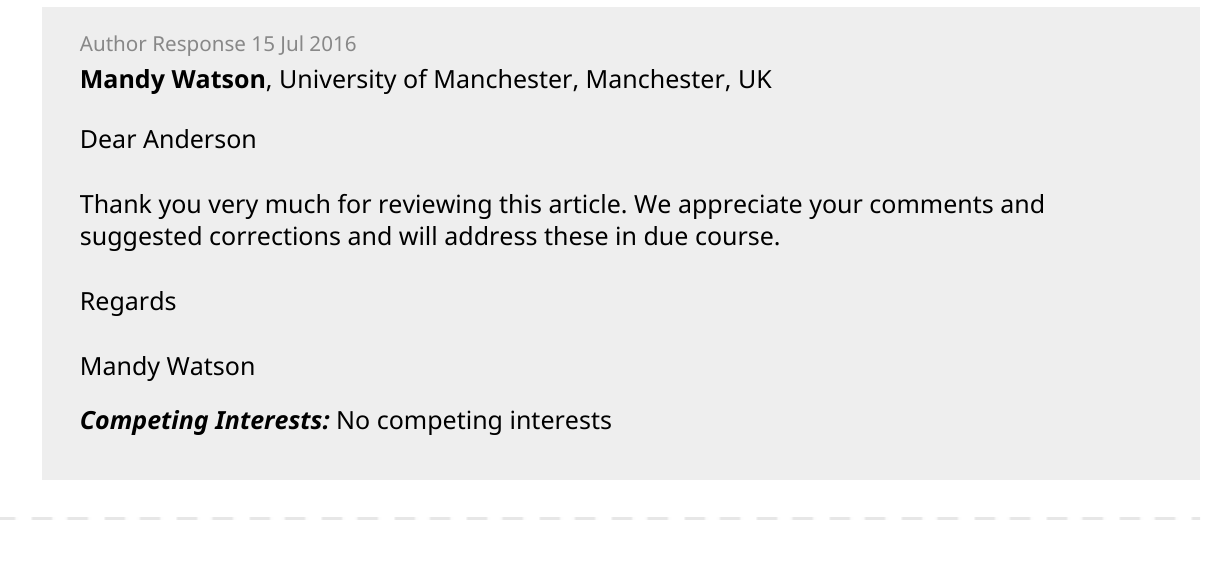
Table 1. Suggest including IC margin